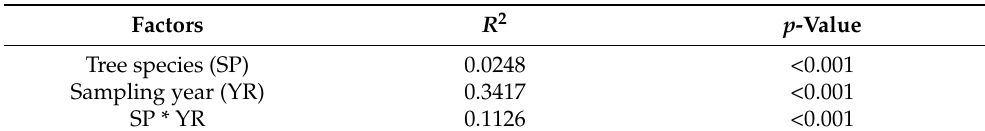
Table 3. Effects of tree species and sampling year on the community structure of ambrosia beetles found in alder and white birch logs from 2016 to 2018. The R -square and p -values were detected using PERMANOVAs.